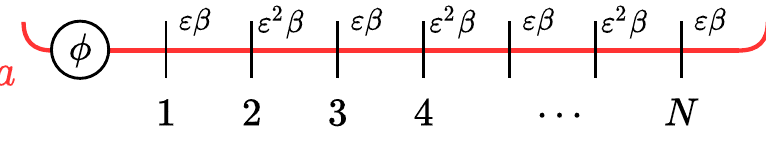
( u , β , φ ) . The aux- a